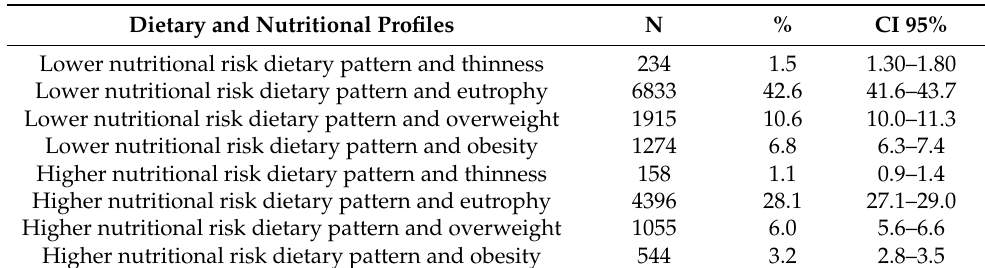
Table 2. Prevalence of dietary and nutritional profiles among Brazilian adolescents ( n = 16,409). National School Health Survey (PeNSE), 2015. Dietary and Nutritional Profiles N % Lower nutritional risk dietary pattern and thinness 234 Lower nutritional risk dietary pattern and eutrophy Lower nutritional risk dietary pattern and overweight Lower nutritional risk dietary pattern and obesity Higher nutritional risk dietary pattern and thinness Higher nutritional risk dietary pattern and eutrophy Higher nutritional risk dietary pattern and